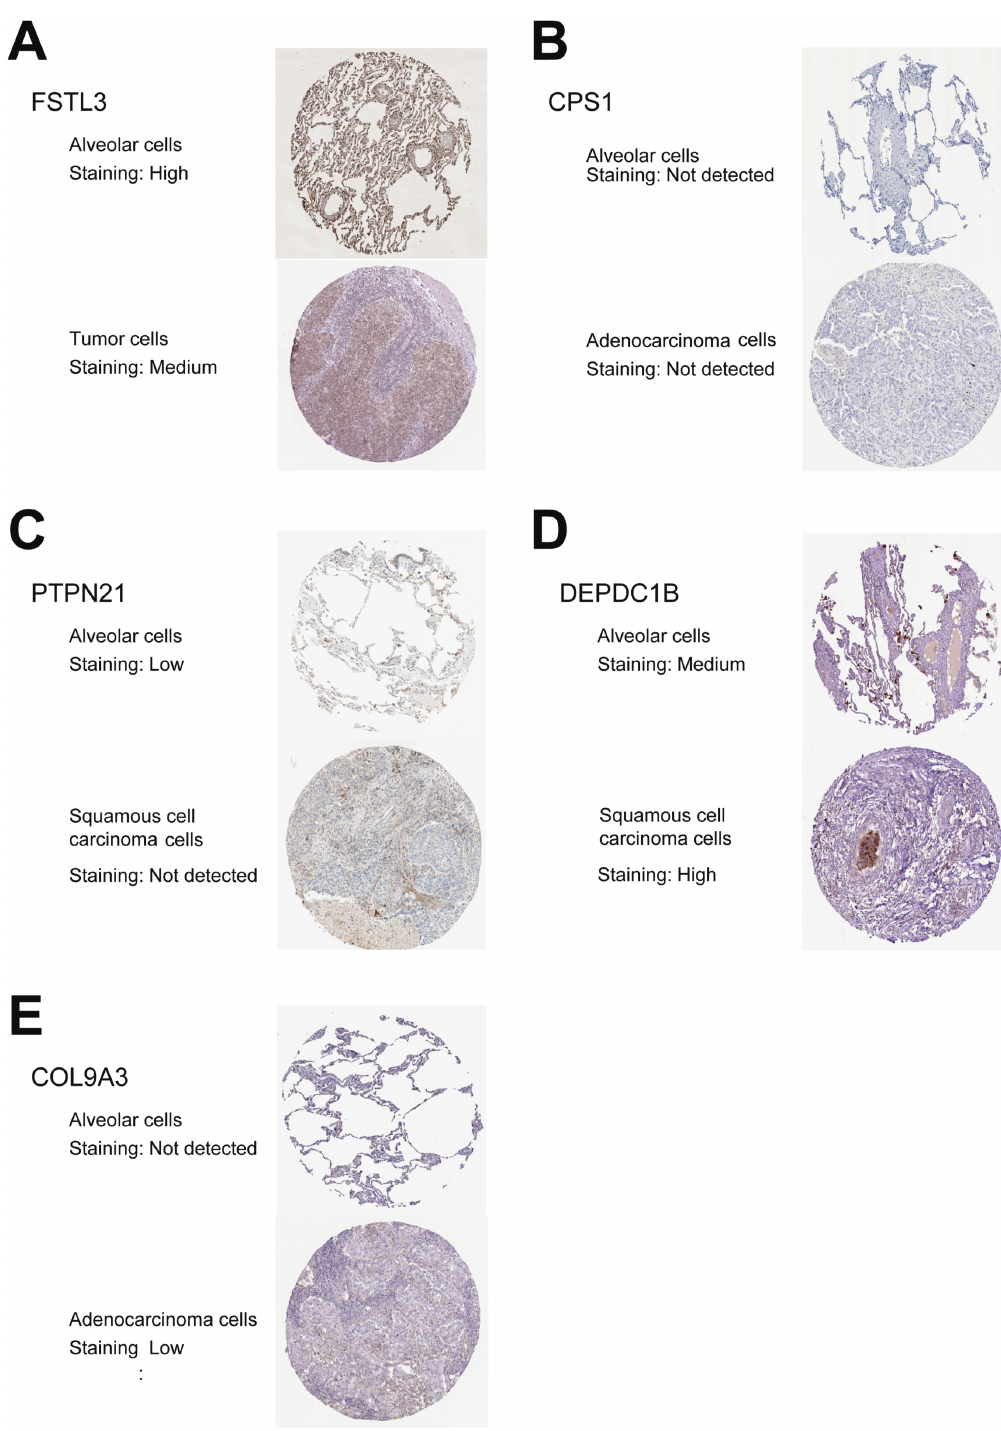
PLOS ONE | https://doi.org/10.1371/journal.pone.0260720 December2,